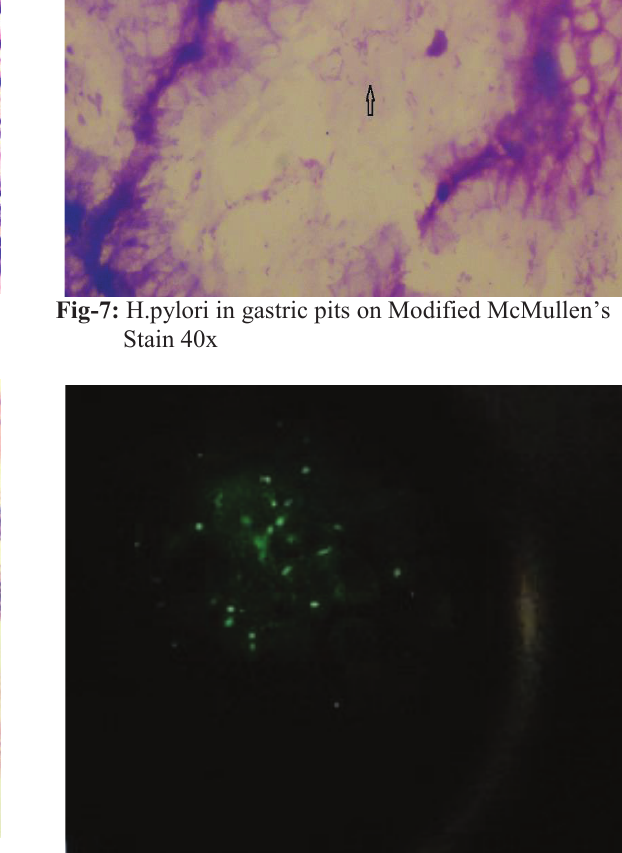
Fig-8: Immunofluorescent stain (Apple green fluorescence)